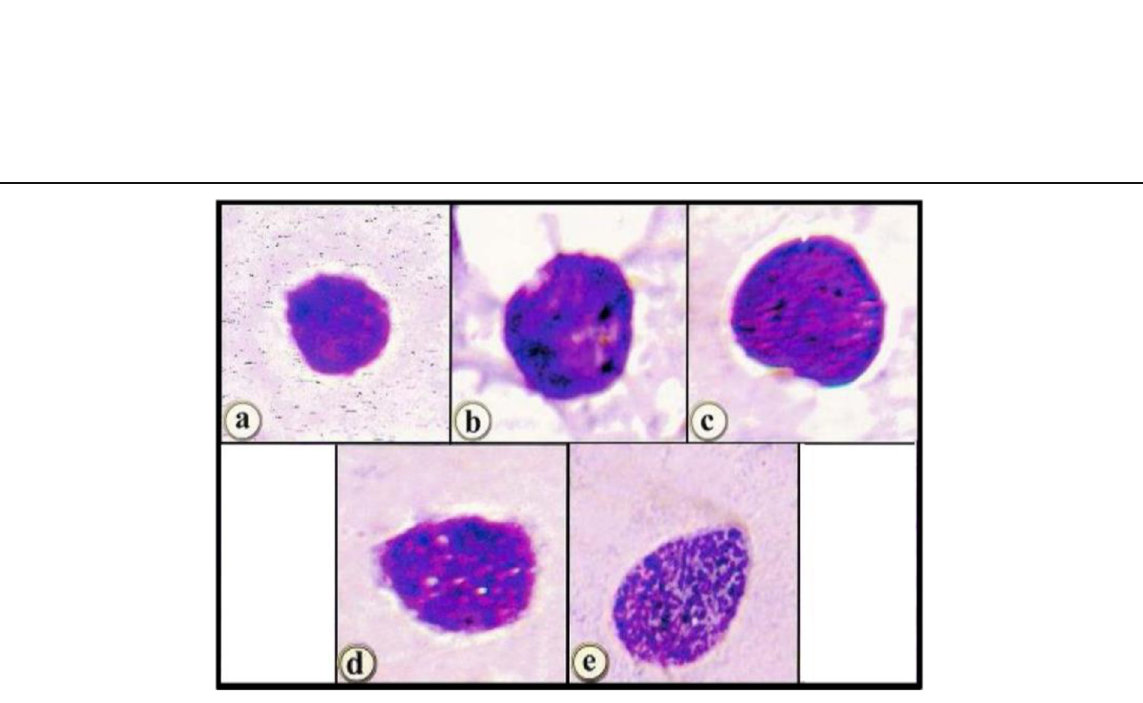
Fig. 4 Morphological changes in granulated cells ( x = 1600). a Normal granulocytes: slightly round, with undifferentiated cytoplasm and nucleus granulocyte. b 40 Gy c 100 Gy and d BA2 20 IJs/ml and e BA2 40 IJs/ml treatments showing granulocyte in oval shape with cytoplasm vacuolation